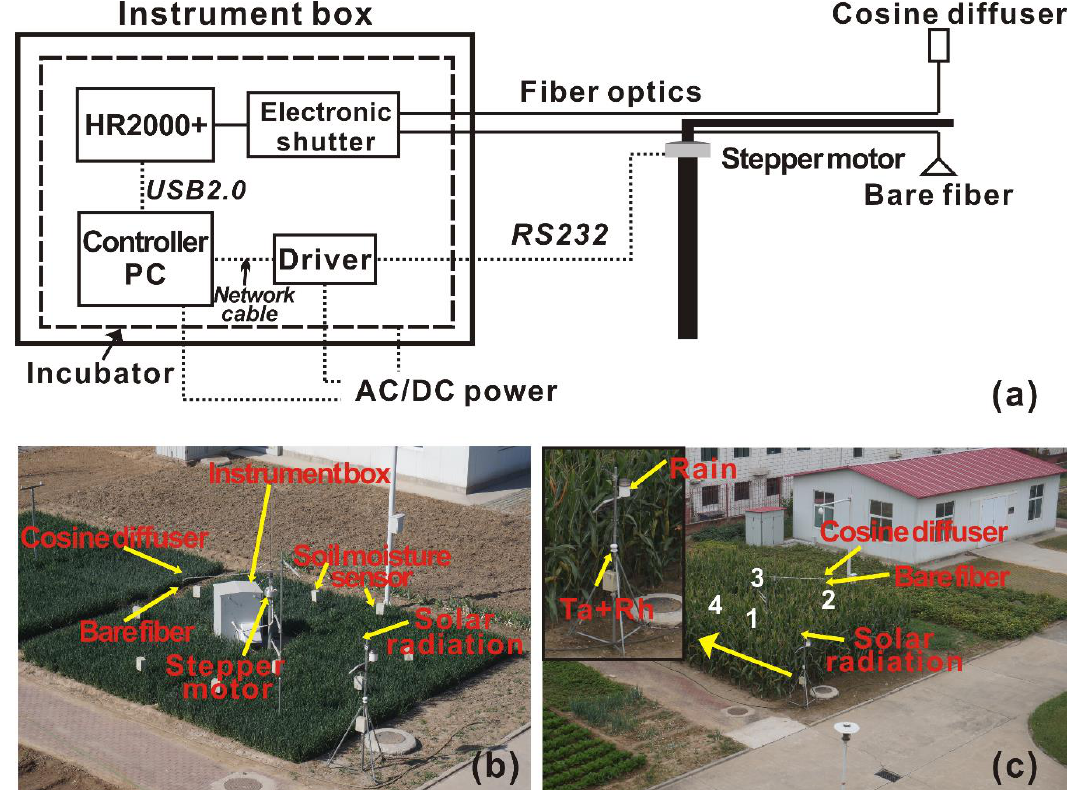
Figure 1. The automated spectroscopy system and the field experimental design for wheat and maize. ( a ) Detailed device configuration for the system. ( b , c ) Description of the data collection and the location of each data acquisition equipment, respectively.